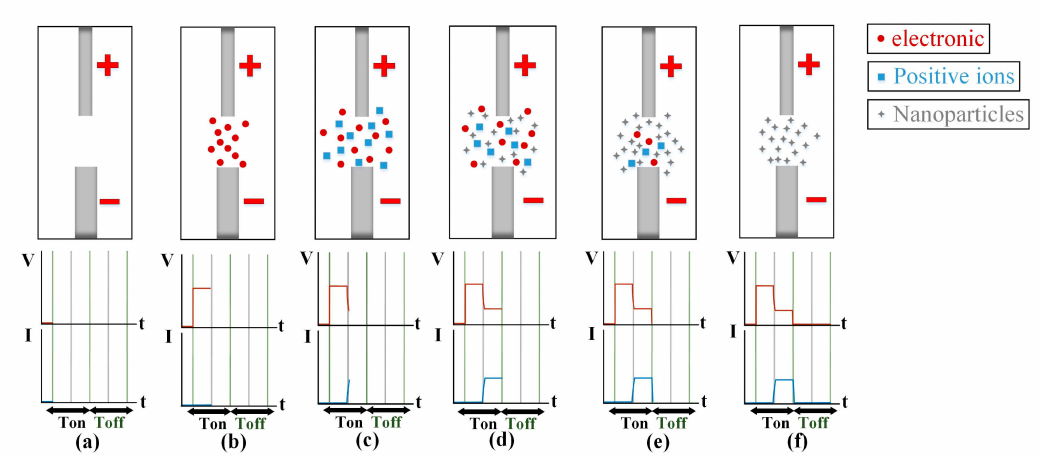
Figure 2. Electrical spark discharge method (ESDM) process: ( a ) prepare to discharge, ( b ) discharge initiation, ( c ) ionization, ( d ) melting e ff ect, ( e ) discharge o ff , and ( f ) insulation